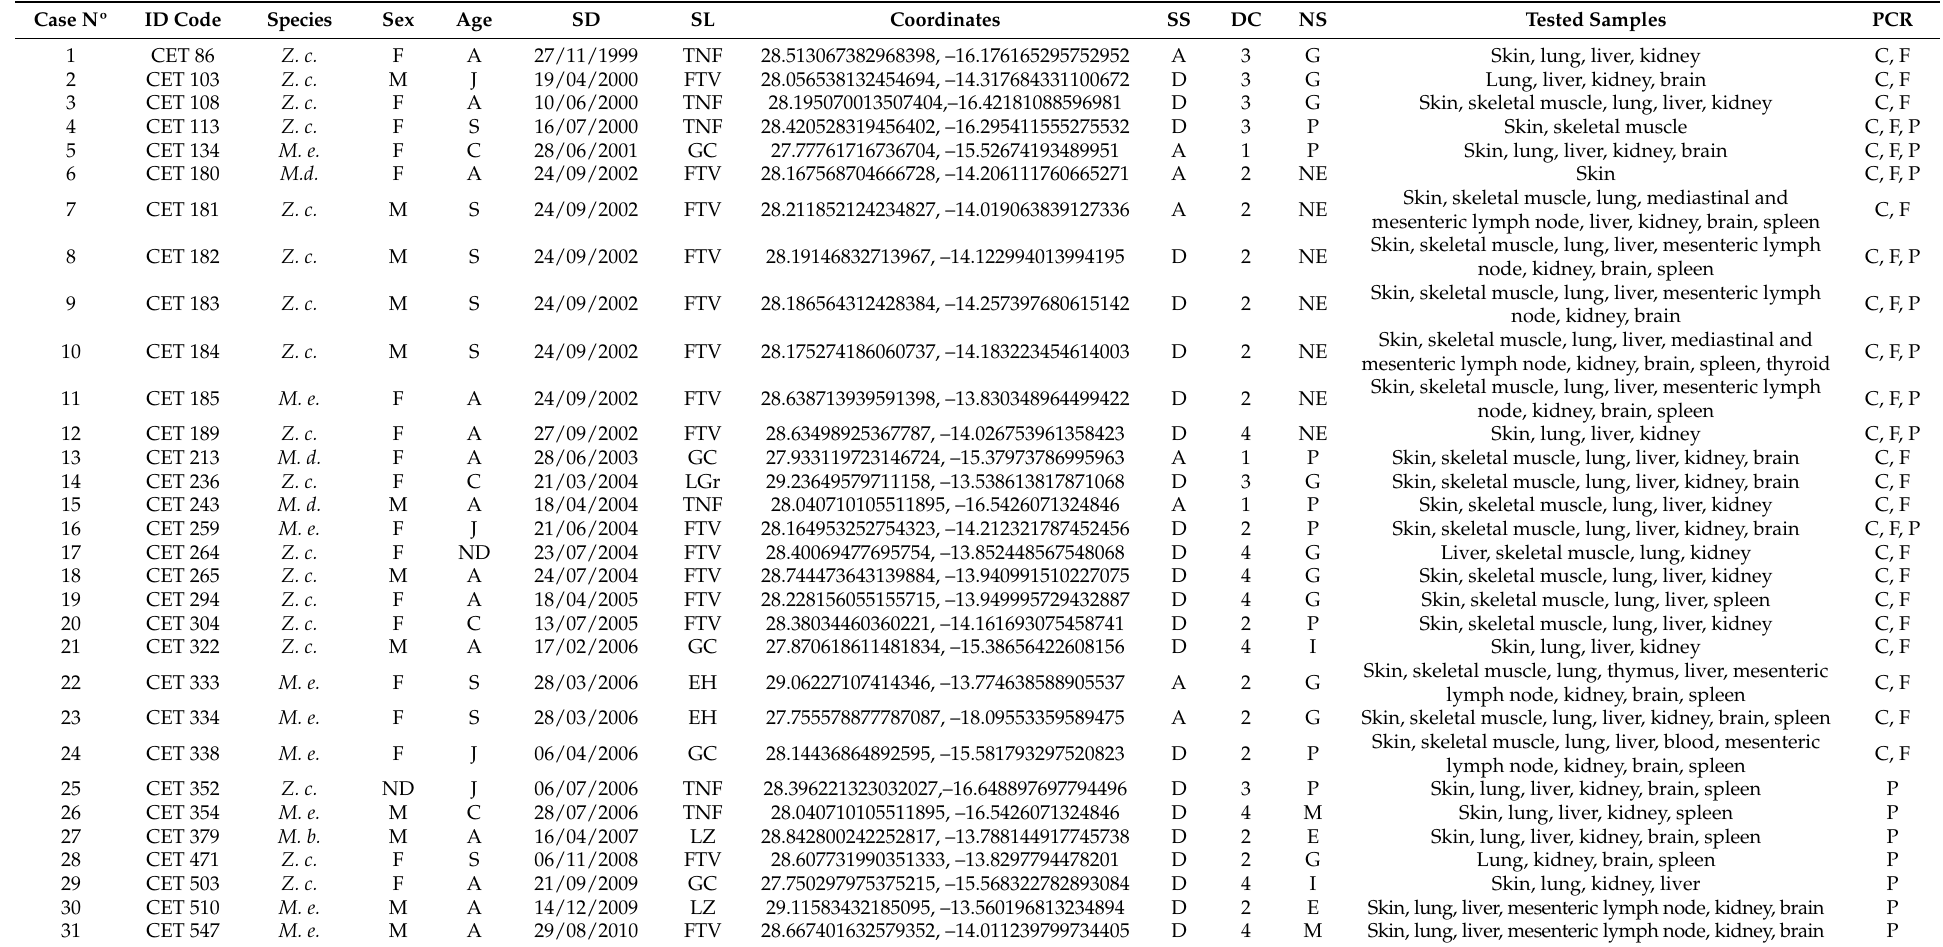
Table 1. Beaked whale specimens included in the present